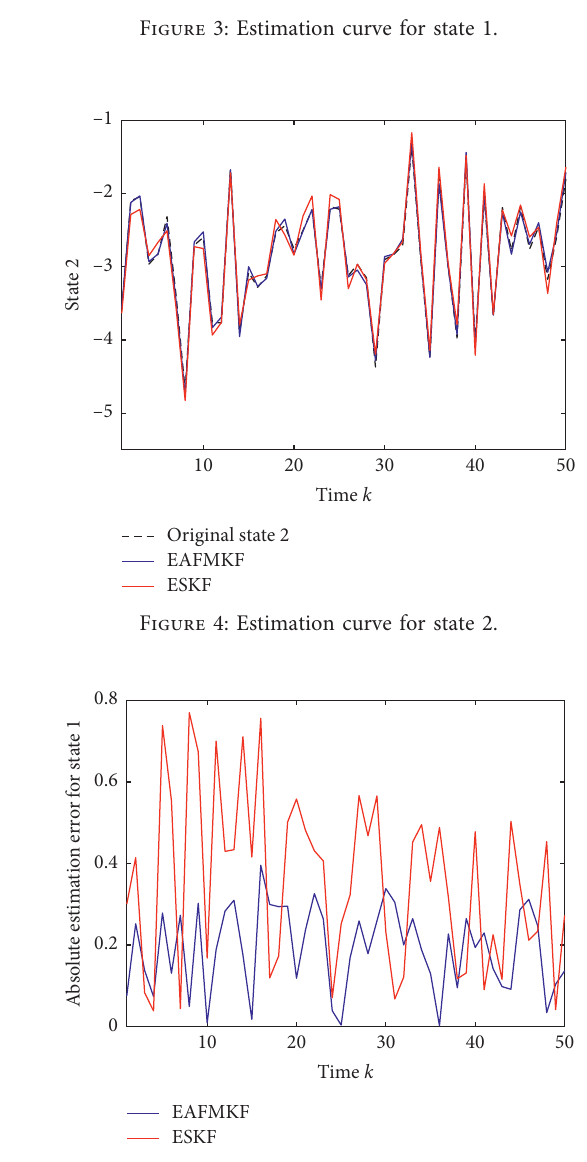
Figure 5: Estimation error curve for state